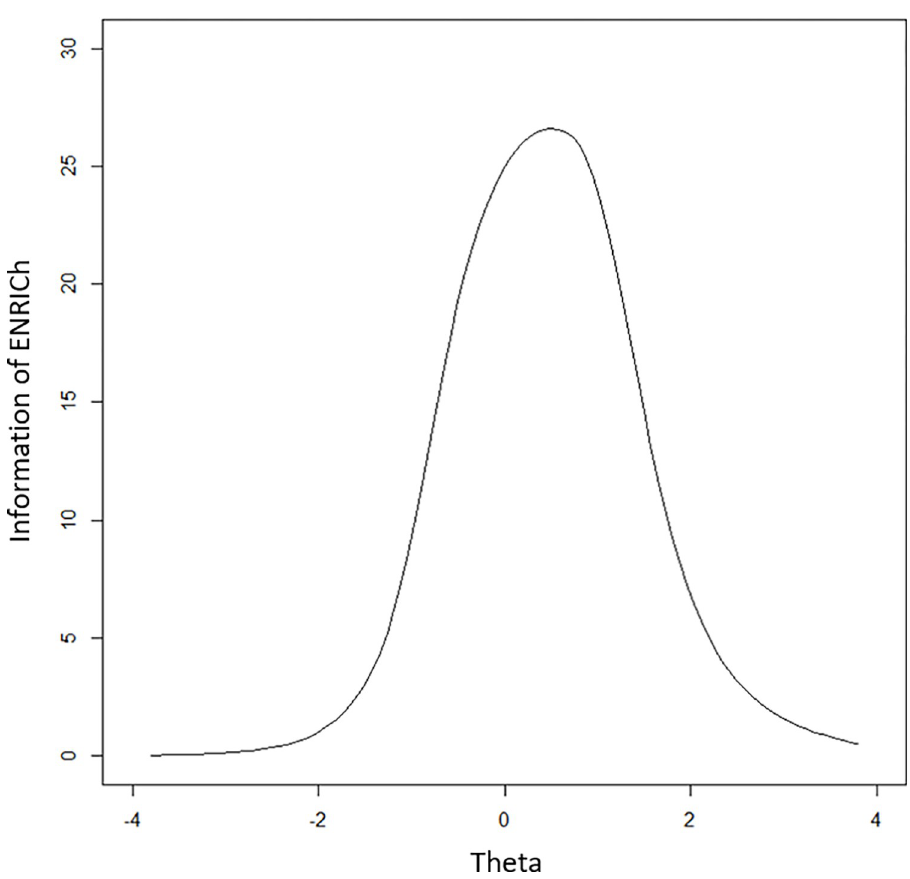
Fig 4. Test information curve of the ENRICh with 12 items.